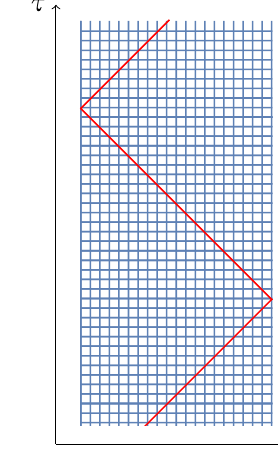
Figure 2: (Left) Spacetime trajectory of a gapless excitation on top of the breathing gas —drawn for the particular case ω ( t ) = ω if t ≤ 0 and ω ( t ) = ω if t > 0 0 1 here—. (Right) In isothermal coordinates ( ξ , τ ) , the trajectory is simply given by ξ ± τ = const. Since we have a conformal boundary condition at the left and right edges, the excitations are simply reflected at the boundaries. This allows to easily trace back observables at position x at time t to their original position at t =